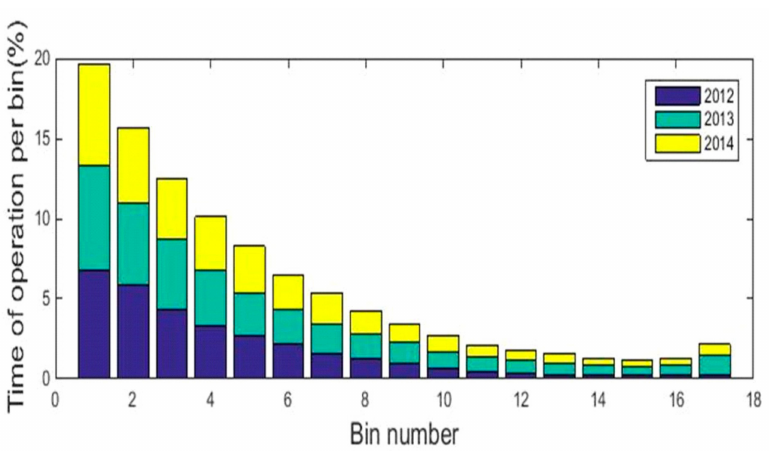
Figure 5. Power bins of 200 kW for the total operating time of the wind turbine with PAO II.